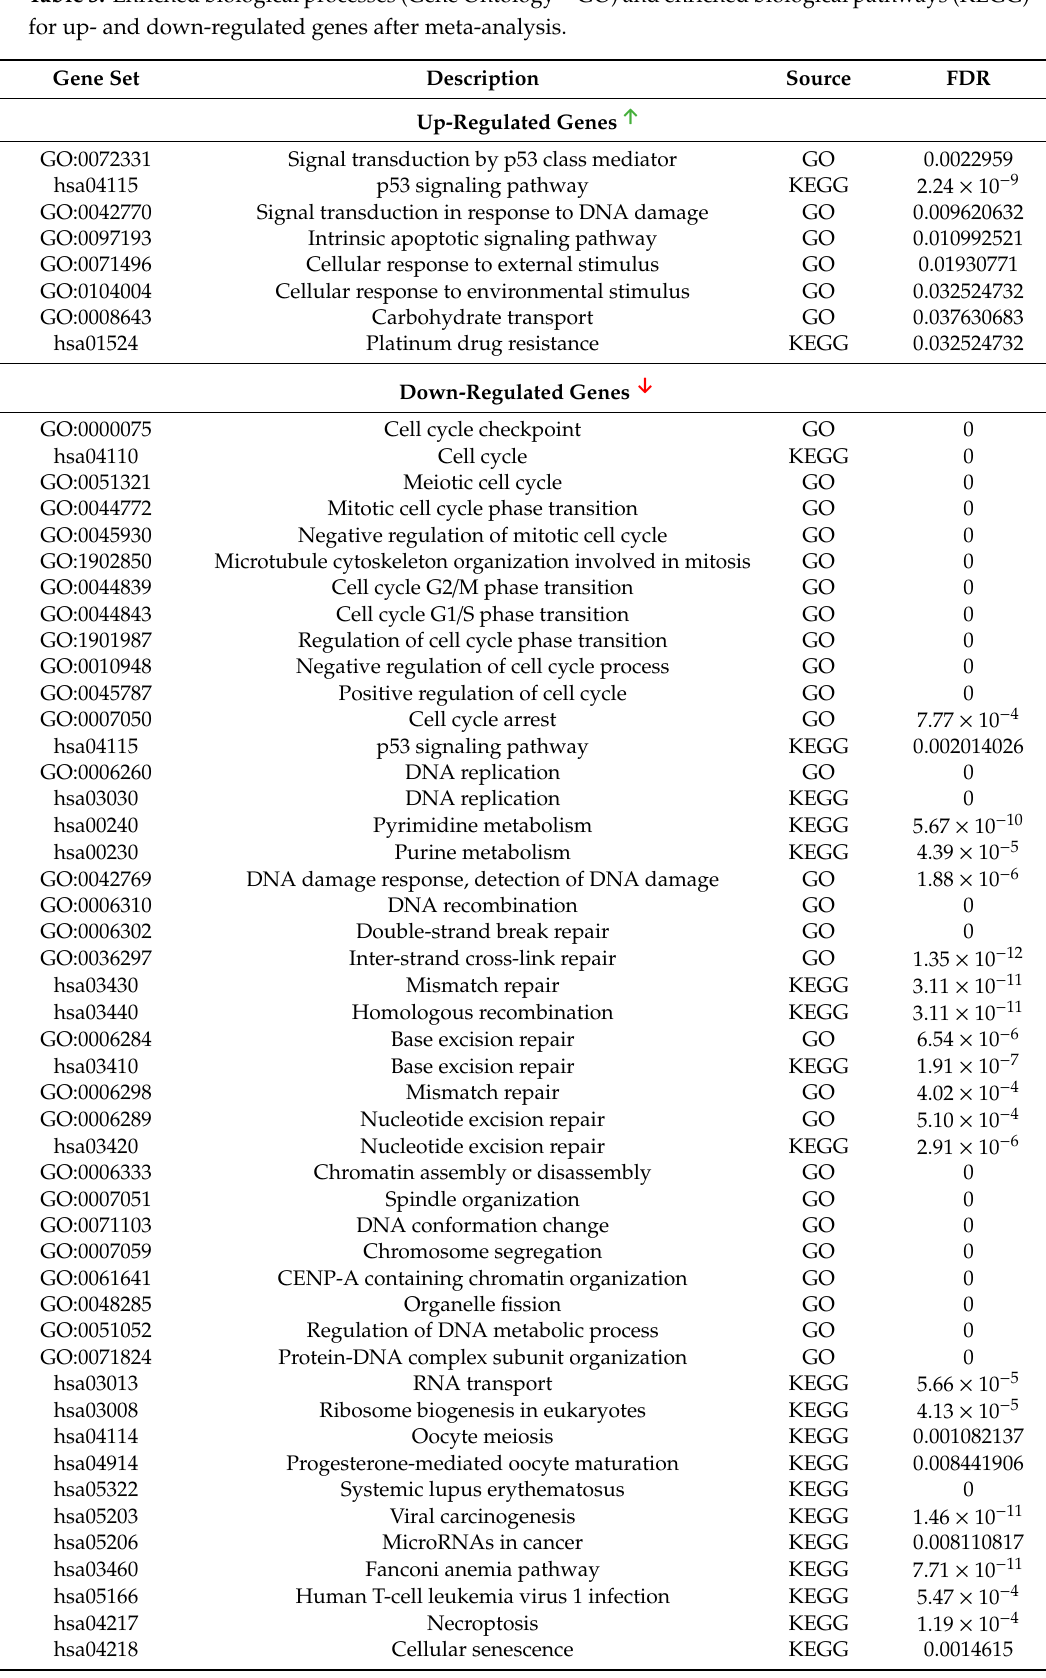
Table 3. Enriched biological processes (Gene Ontology—GO) and enriched biological pathways (KEGG) for up- and down-regulated genes after